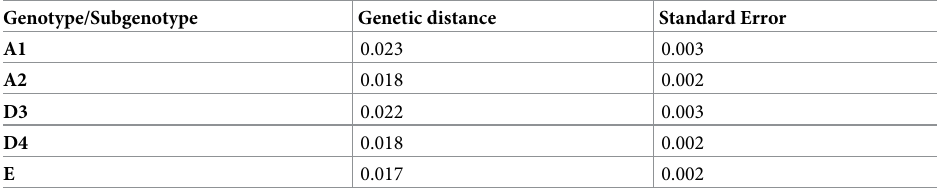
Table 2. Divergence within HBV genotypes/subgenotypes isolates present in